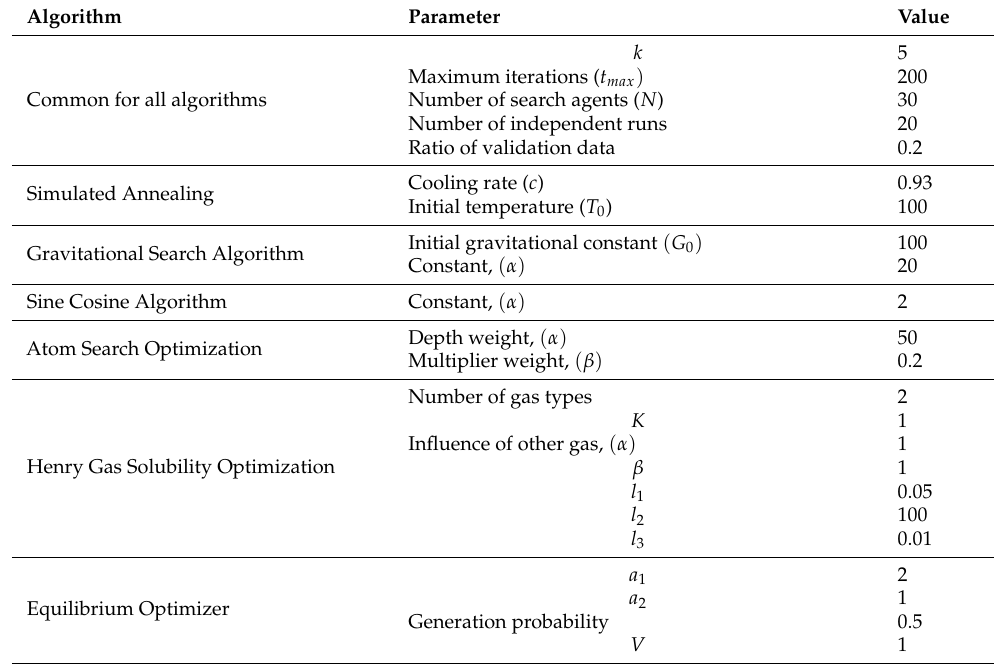
Table 2. Parameter settings of all